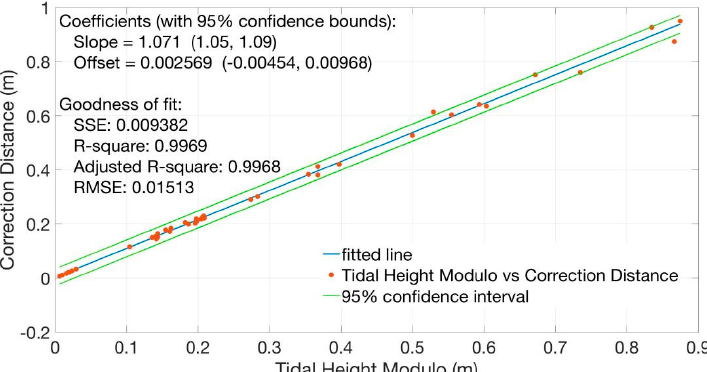
Figure 4. Tidal height modulos and the corresponding tidal positioning corrections of the tracks with the fitting of the two.